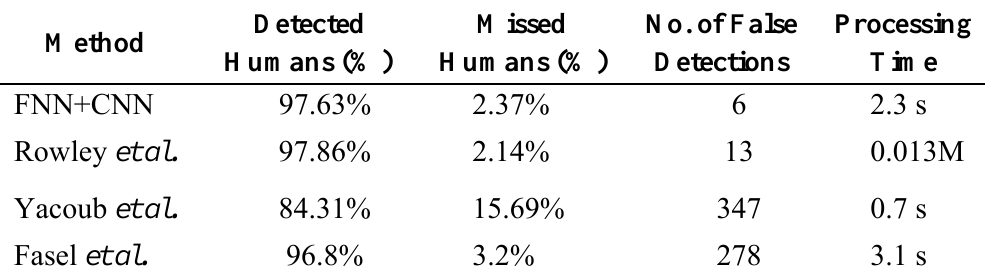
Table 1. Detection rate for set 1, using different methods.